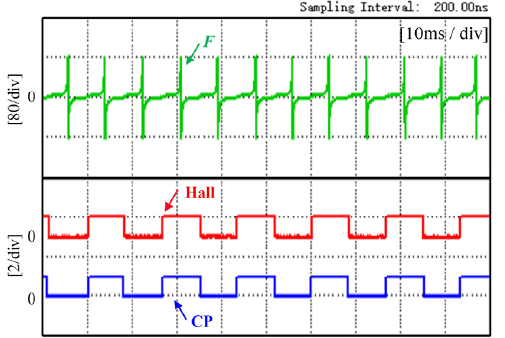
Figure 11. Experimental waveform under the condition of 300 r/min speed and 0.5 N·m